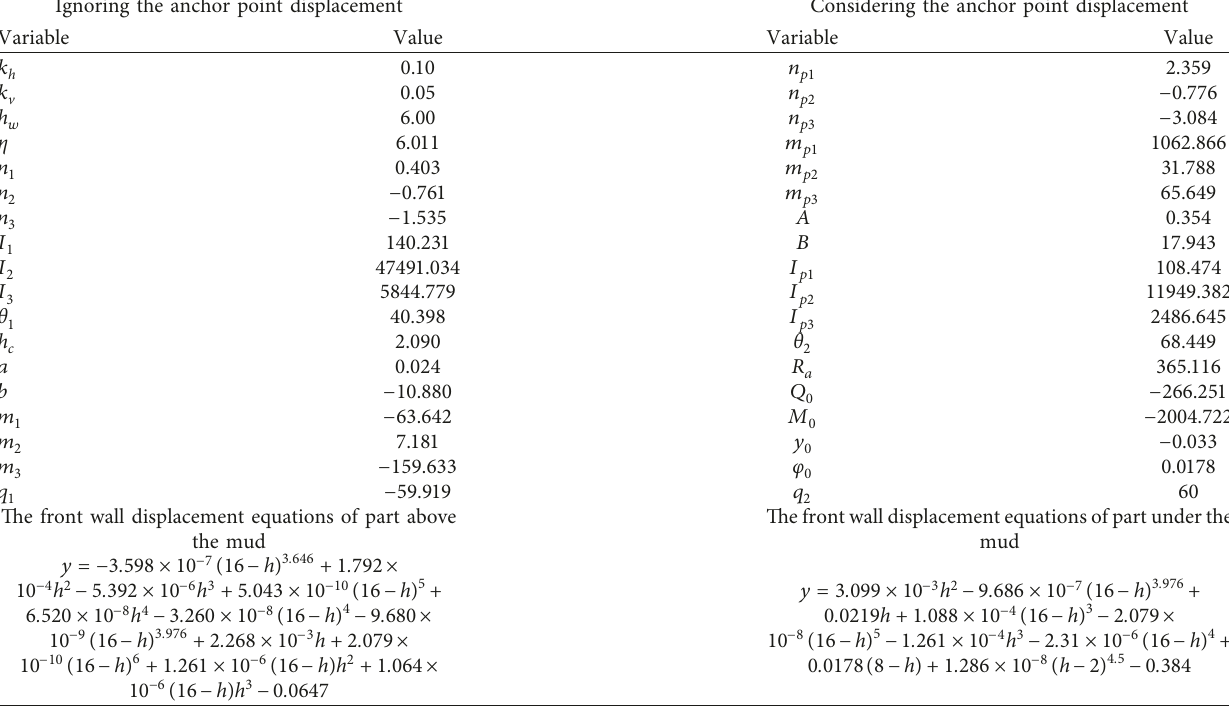
Table 2: Calculation data of front wall’s displacement.